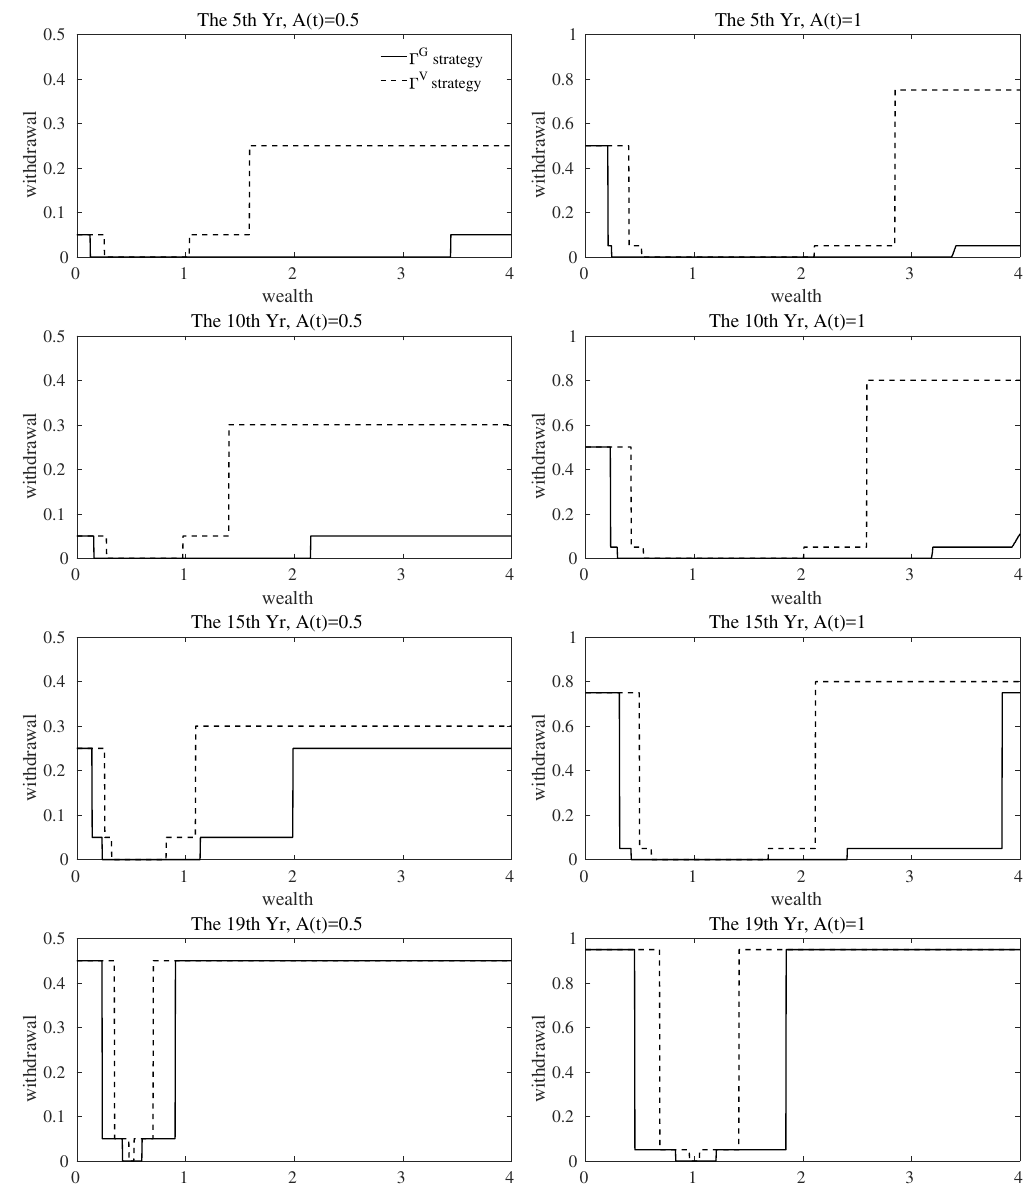
Figure 2. Optimal withdrawal as a function of wealth, respectively under the two strategies for guarantee account levels 0.5 and 1 at the end of 5th, 10th, 15th and 19th years of a contract with a maturity of 20 years. The market conditions are r = 1% and σ =